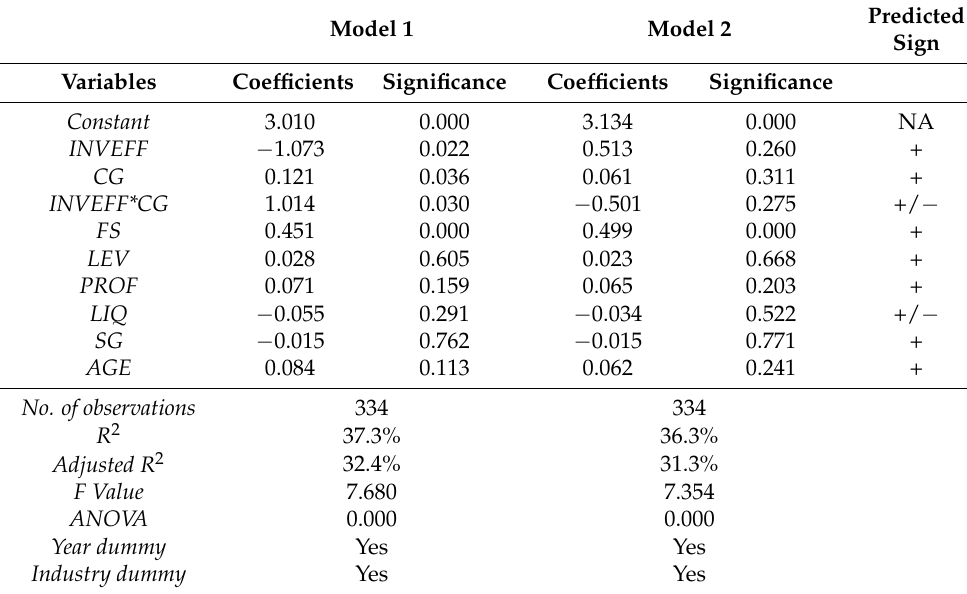
Table 5. Investment efficiency and performance-related